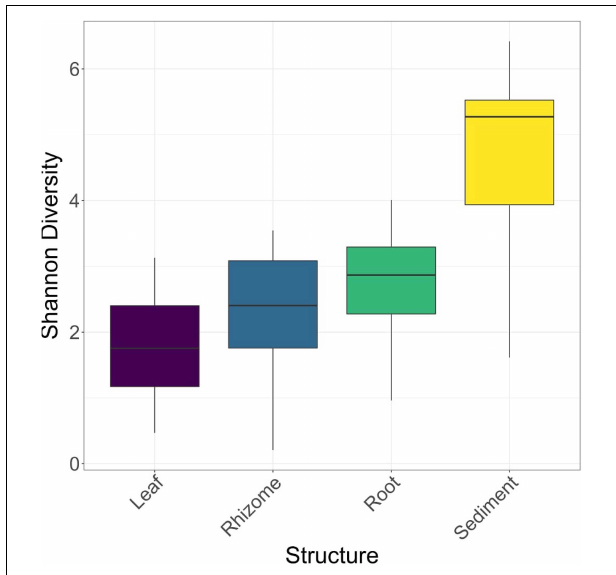
FIGURE 3 | Box plots of Shannon diversity for each location.